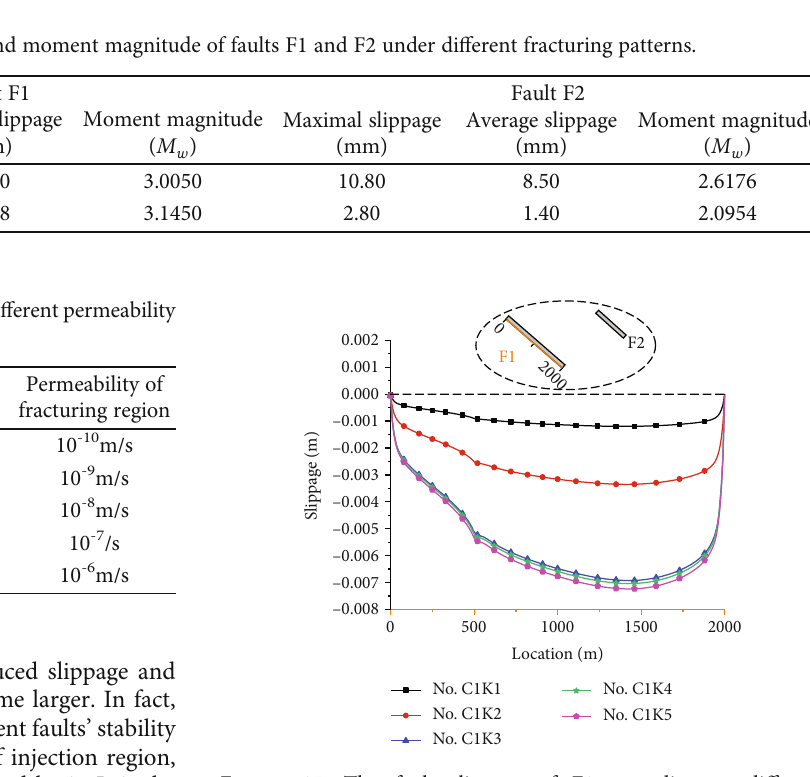
Figure 15: The fault slippage of F1 according to di ff erent permeability (Nos.